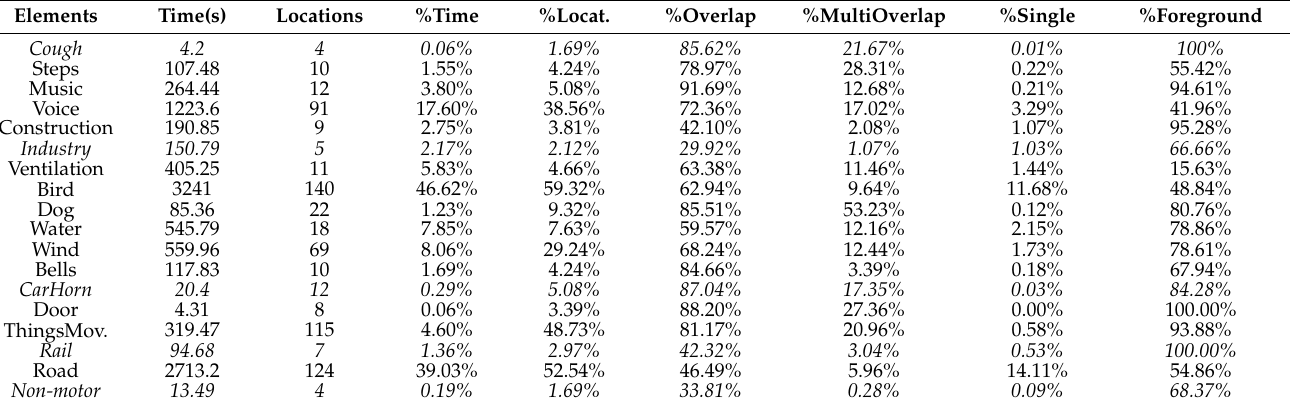
Table 2. Dataset’s internal statistics for the 2021 campaign (only fine labels appearing in 4 locations or more). The elements that are marked in italics were not present in the 2020